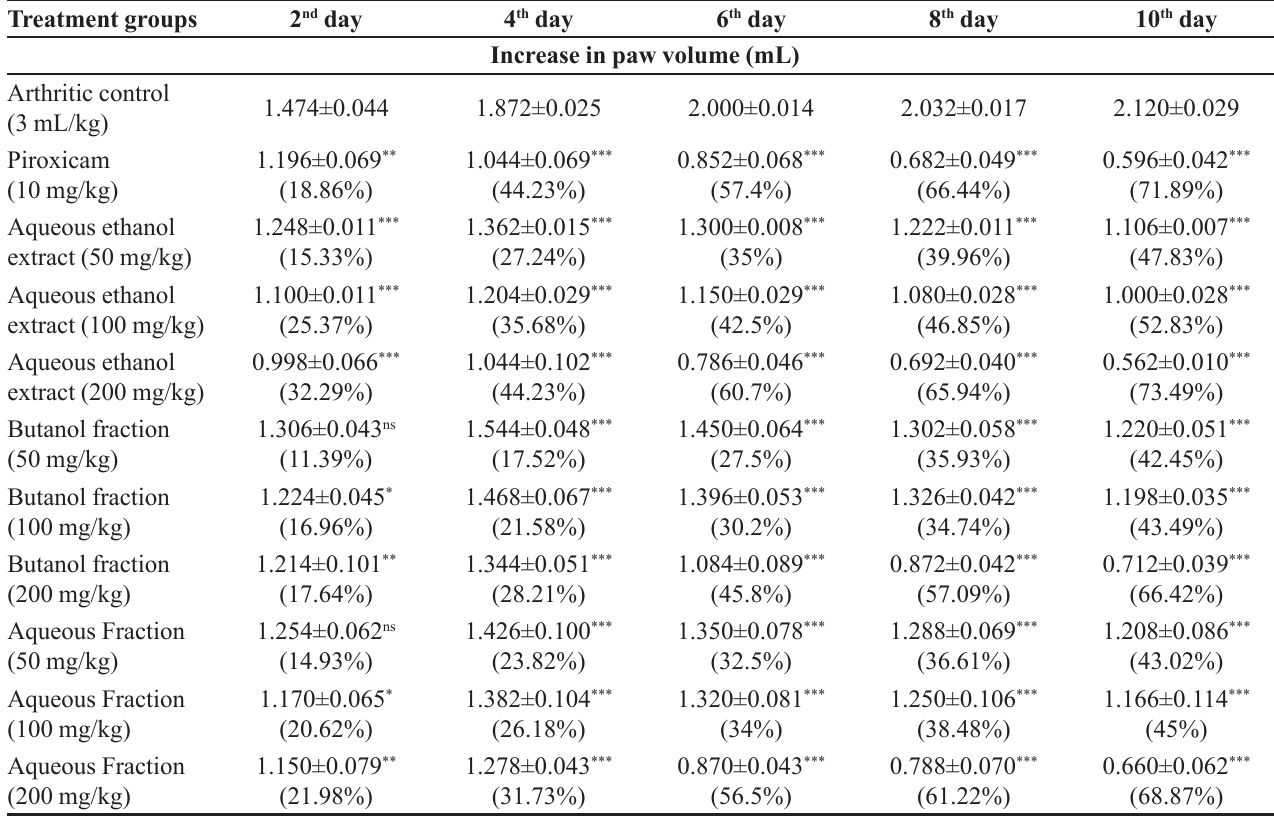
TABLE IV - Effect of Ribes alpestre on Paw volume in Formaldehyde induced arthritis Treatment